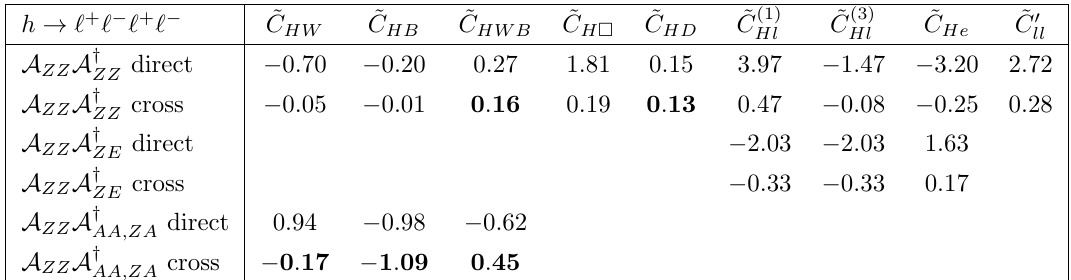
Table 5 . Contribution to a ( eeee )